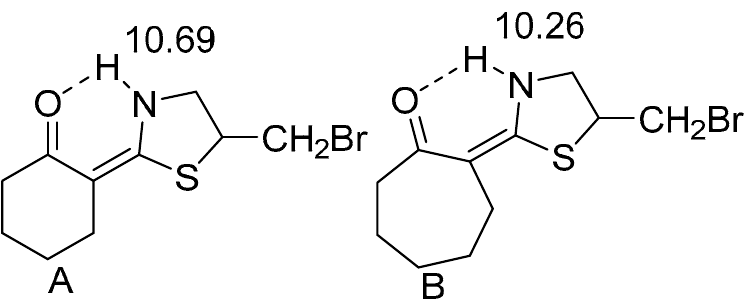
Figure 6. Illustration of the importance of ring size. Taken from [28]. C shows the effect of a six-membered ring. Taken from [29]. The numbers are the NH chemical shifts in ppm. Another comparison is made in Figure 7, in which the NH is hydrogen bonded to